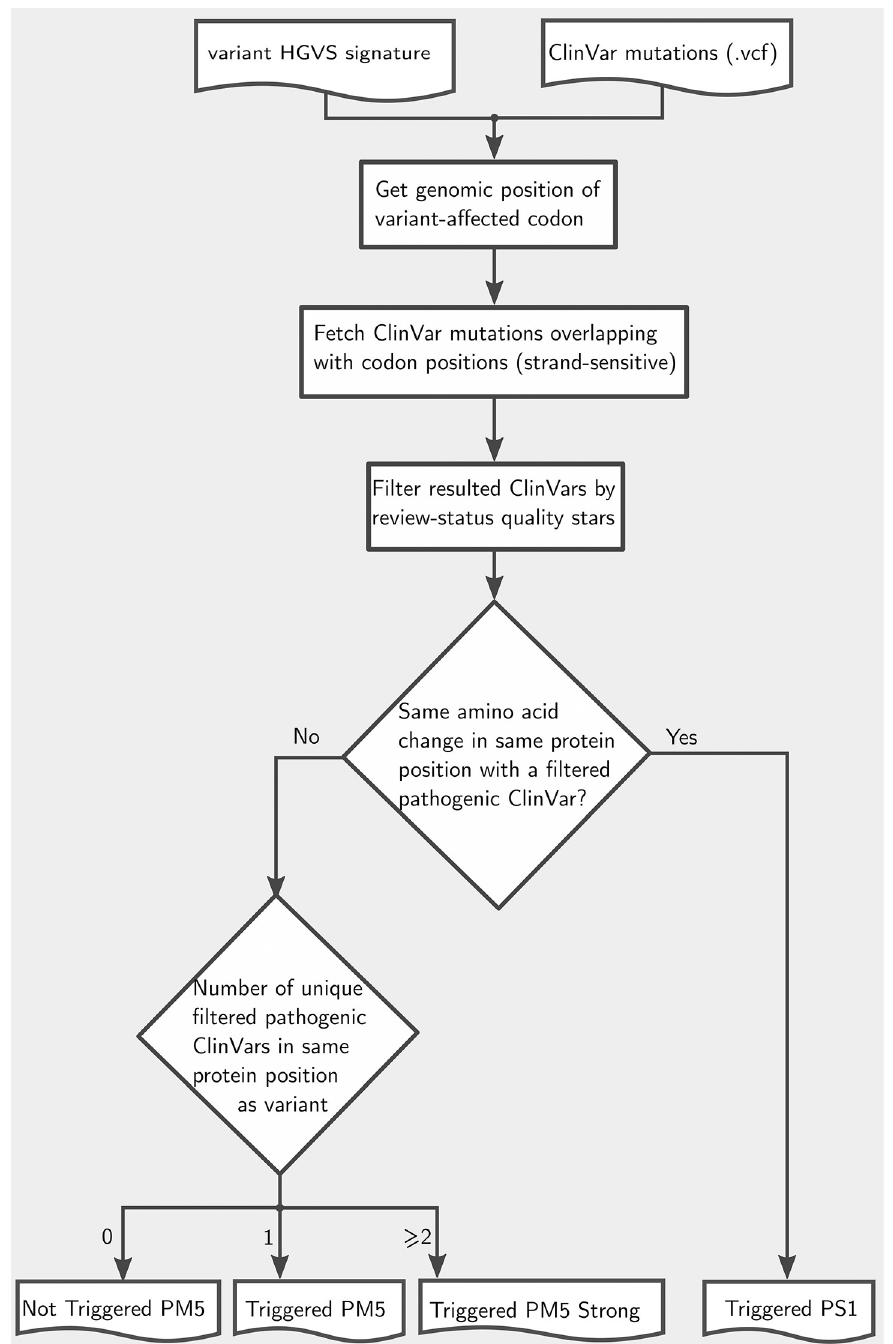
Fig 6. Conceptual flowchart for examining PS1 and PM5 (PM5